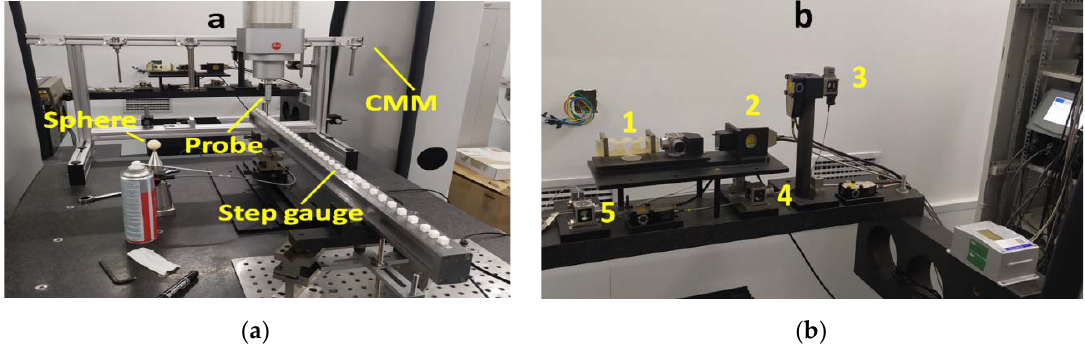
Figure 3. The step gauge measurement system;( a )actual calibration scenario of step gauge measurement system;( b )the critical optical system. Among this, 1 is the refractive index tracker to compensate the laser wavelength change, 2 is the plane interferometer, 3, 4 and 5 are the three-way length measuring interferometers from a single-frequency laser.